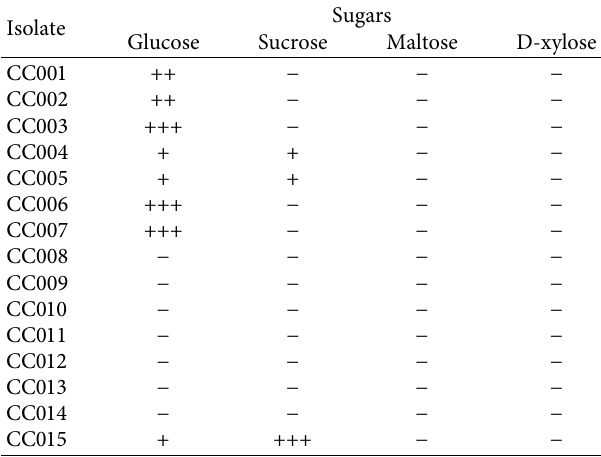
Table 1: Fermentative capability of yeasts isolated from Myrciaria dubia